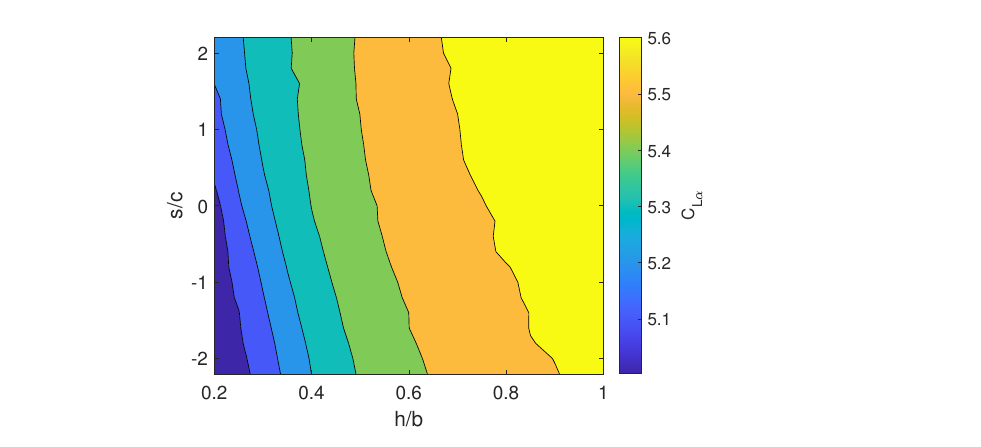
Figure 6. Lift slope ( C L α ) for given stagger over chord (s/c) and height over span (h/b) ratios [20].